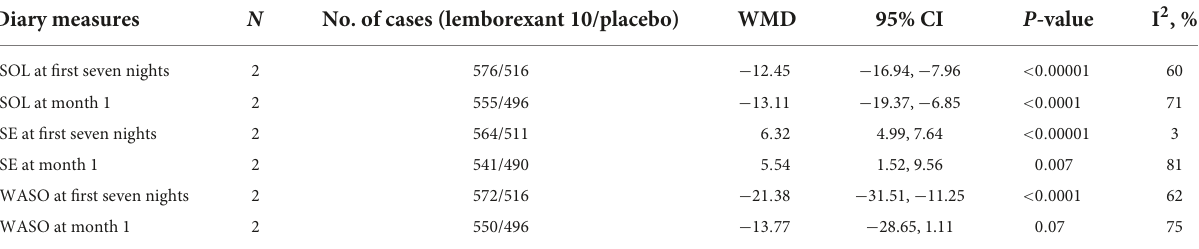
TABLE 6 The mean changes of efficacy outcome (diary measures) results from baseline in lemborexant 10 vs. placebo. Diary measures N No. of cases (lemborexant 10/placebo) WMD